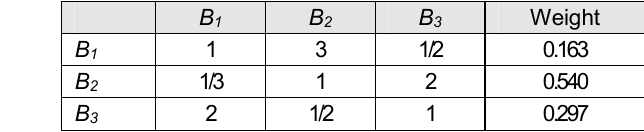
Table 8 – Matrix of the relevant importance of alternatives in relation to attribute A 3 (Mobility) Таблица 8 – Матрица релевантной значимости альтернатив по отношению к атрибуту A 3 ( Мобильность ) Tabela 8 – Matrica relevantne važnosti alternative u odnosu na atribut А 3 (mobilnost)